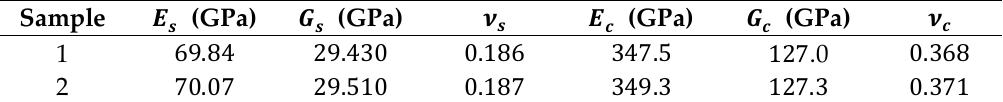
Table 2. Elasticity constants of the glass substrates and the as-deposited tungsten film. Sample